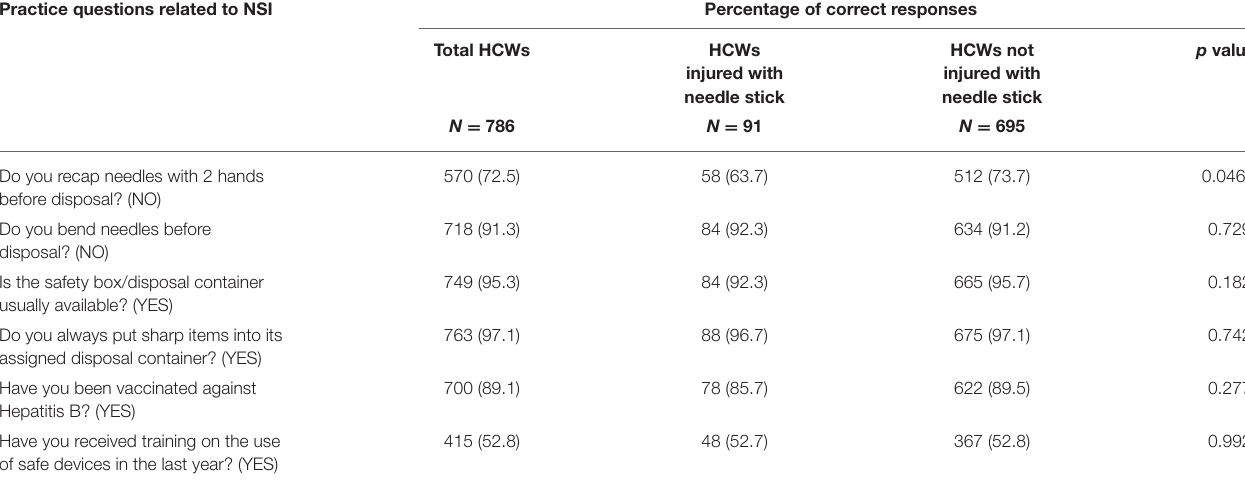
TABLE 6 | Percentages of correct responses to the practice questions related to